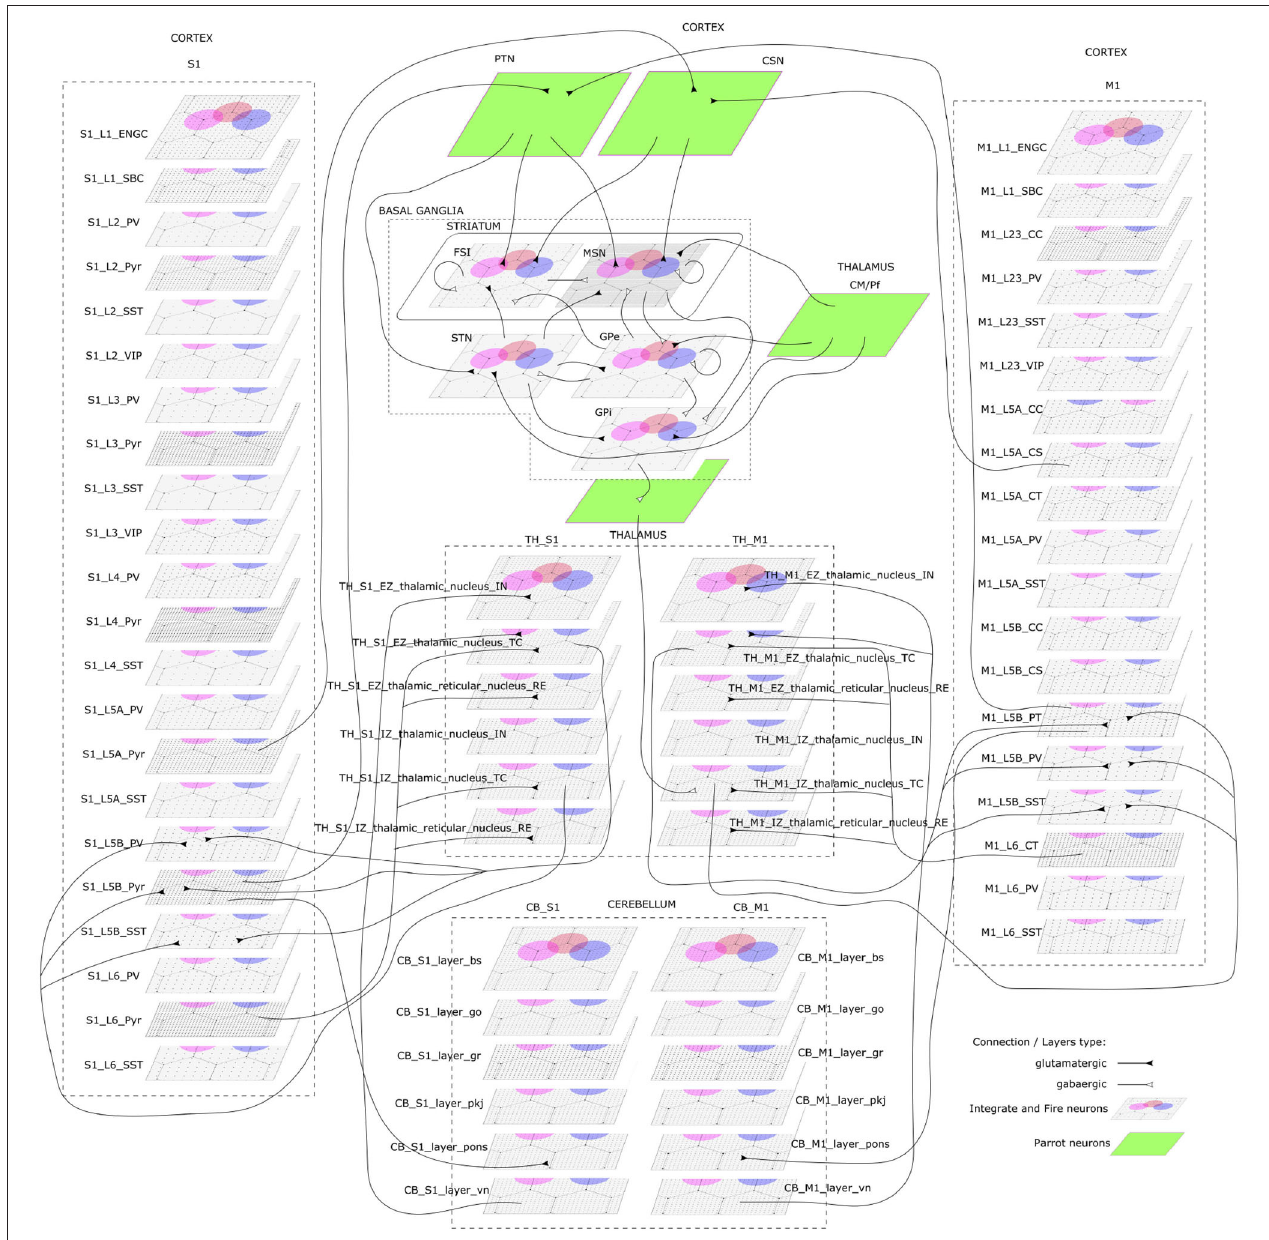
FIGURE 4 | The cortico-basal ganglia-cerebellar-thalamic (CBCT) model of the rodent brain. The model includes the cortex (S1, M1), the basal ganglia (BG), the cerebellum (CB), and the thalamus (TH). Within each region, neural populations are topologically organized in 2D-layers of 1 × 1 mm 2 , with dots on their surface indicating the spatial allocation and density for each neuron type. Only main inter-regional connections are displayed for clarity. Layers in green correspond to the interface between different regions or simulated input, which are implemented using NEST’s parrot neurons that just relay incoming spikes to multiple